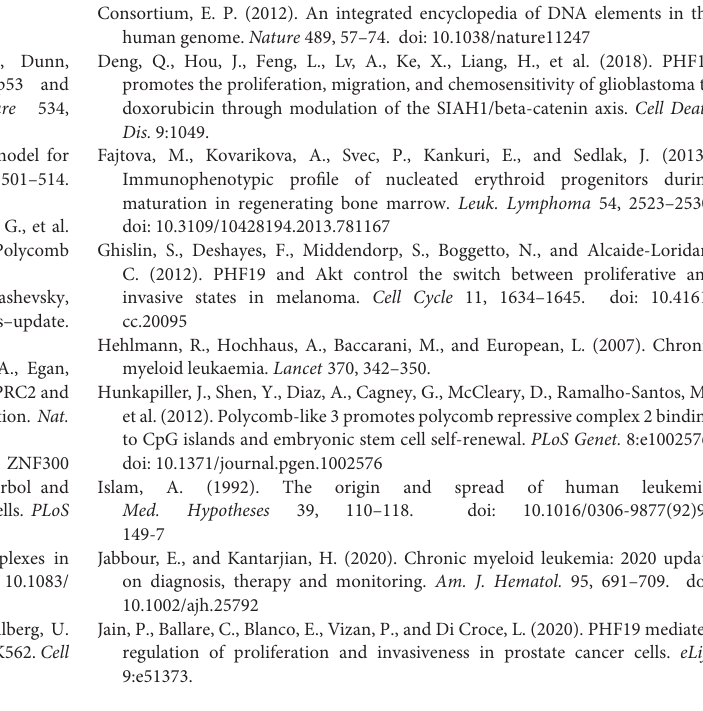
Supplementary Figure 1 | (A) Representative analysis of cell cycle phases in shCT and sh PHF19 #2. (B) Representative analysis of BrdU incorporation analysis in shCT and sh PHF19 #2. (C) Cell growth of cells infected with an shCT and shPHF19#2 in the absence or presence of 10 nM Ara-C for 6 days. Supplementary Figure 2 | (A) Genomic distribution of ChIP-seq peaks of PHF19. The spie-chart represents the genomic distribution of ChIP-seq peaks (outer circle) corrected by the whole-genome distribution of each gene genomic feature (indicated in the background circle distribution). (B) PHF19 ChIP-seq screenshots modified from UCSC genome browser of genes validated in Figure 3B . (C) Genomic distribution of ChIP-seq peaks of MTF2 (in shCT and sh PHF19 #2). The spie-chart represents the distribution of peaks corrected by the genome-wide distribution of each gene genomic feature (indicated in the background circle distribution). (D) MTF2 ChIP-seq screenshots modified from UCSC genome browser of genes validated in Figure 4B . (E) Accumulative growth of cells infected with an shCT and sh PHF19 #2 in the absence or presence of different doses of Imatinib for 6